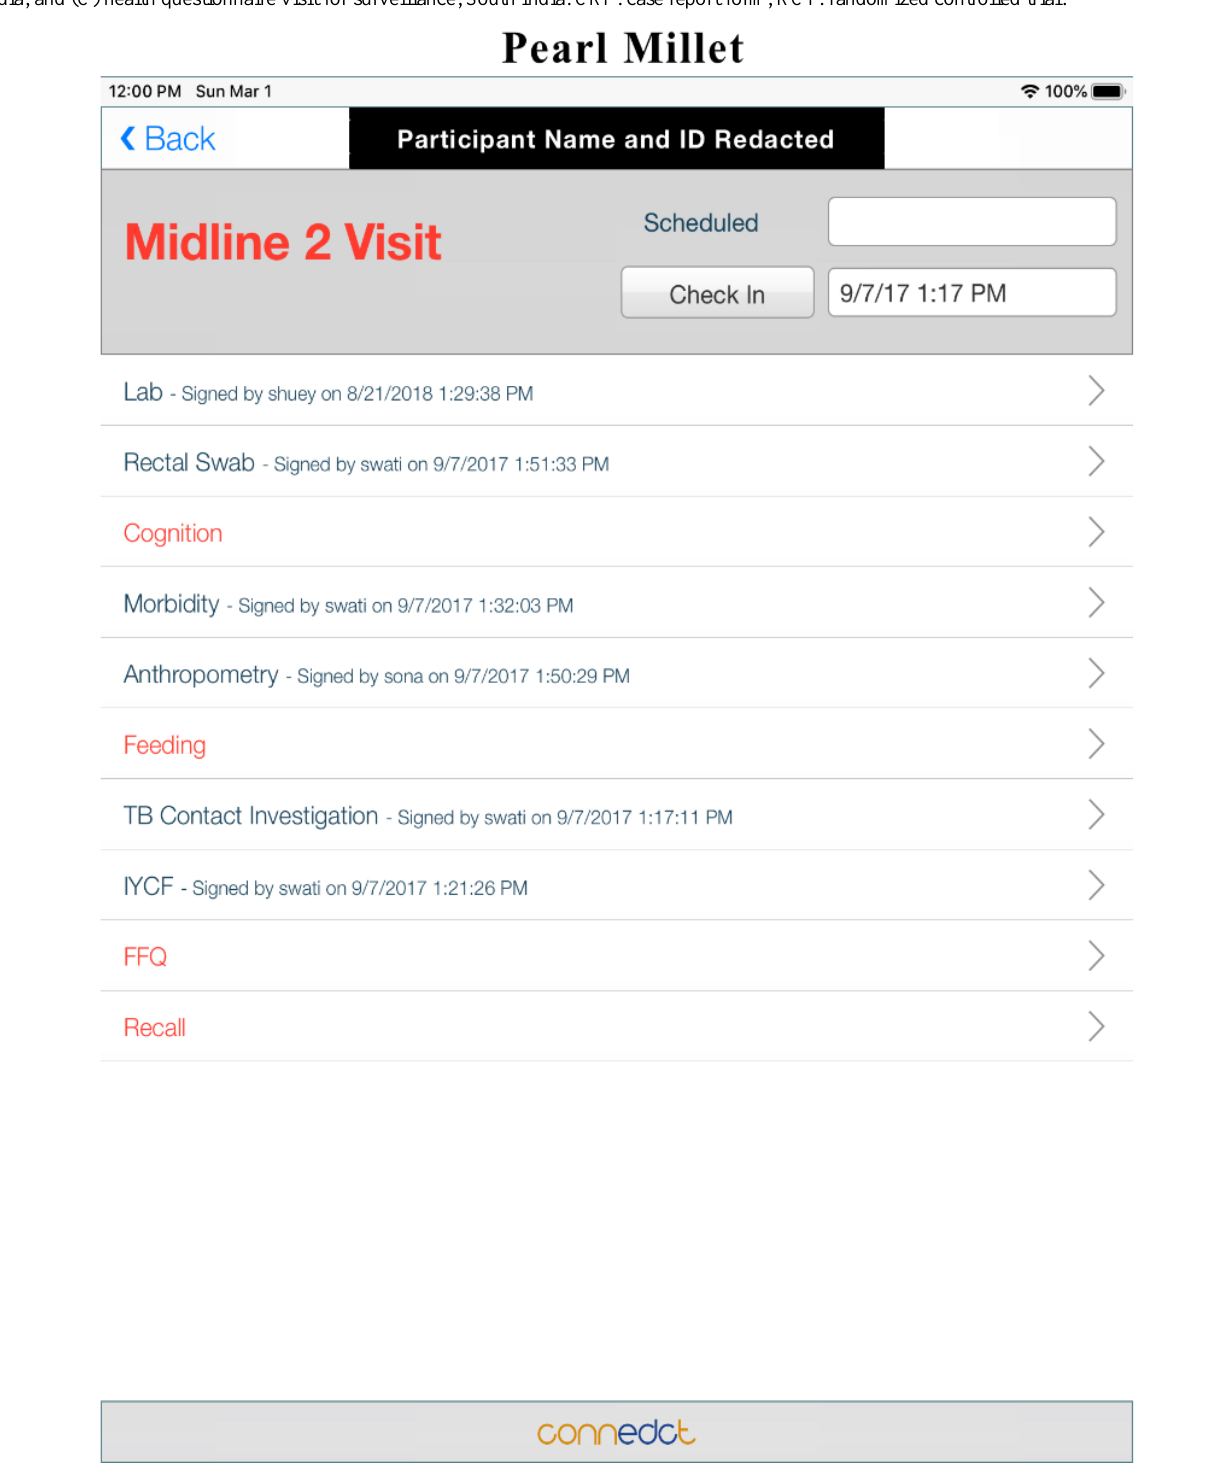
Figure 4. Example of display of all CRFs required for (A) baseline visit, for clinical setting: FeverPhone, Ecuador; (B) baseline visit for RCT, South India; and (C) health questionnaire visit for surveillance, South India. CRF: case report form; RCT: randomized controlled